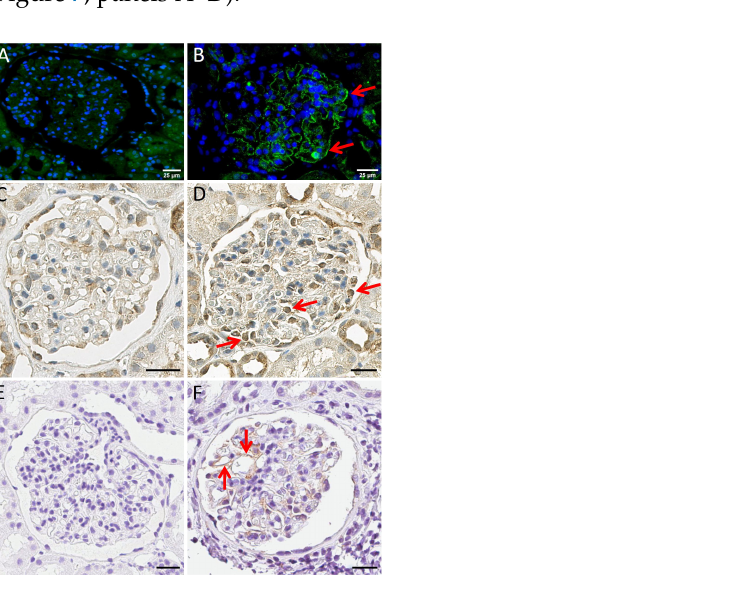
Figure 7. Immunofluorescence of IL7R alpha with normal control and MCD (panels A , B ), and immunohistochemistry of IL12RB2 with normal control and MCD (panels C , D ), as well as of AXL tyrosine kinase receptor normal control and MCD (panels E , F ). Red arrows point toward positive glomerular areas in ( B , D , F ). MCD panels ( B , F ) show fine granular positivity along the capillary walls. Positivity in MCD panel ( D ) is mostly located in nuclear and perinuclear areas of podocytes. Control samples are either entirely negative ( A , E ) or show clearly less and possibly unspecific positivity ( C ). Scale bars in all images are 25 µ